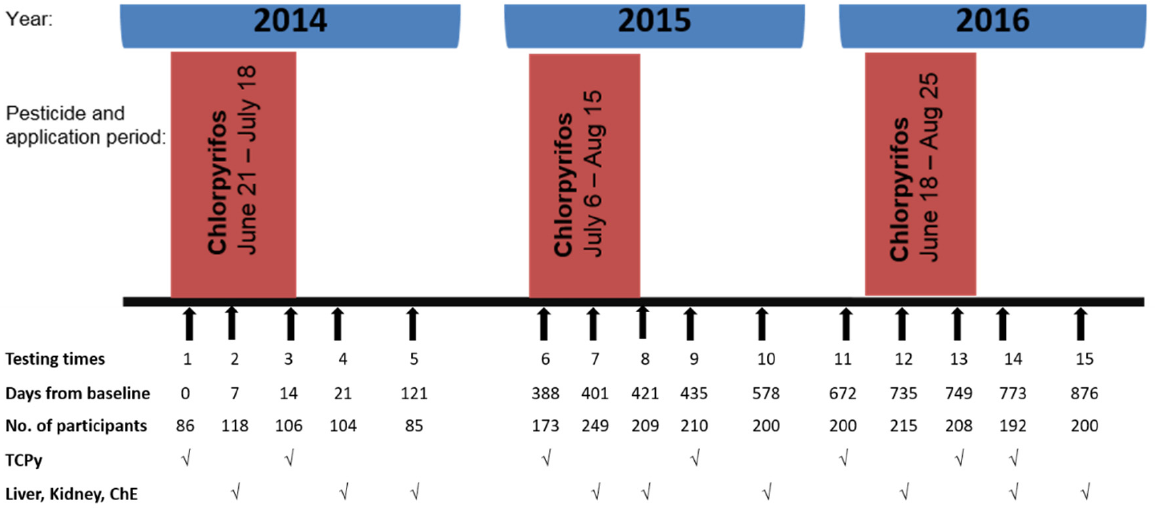
Figure 1. Chlorpyrifos application, days from baseline of the testing timepoints, number of participants, and availability of liver and kidney function measures and urinary TCPy measurements across the 3 years of study.